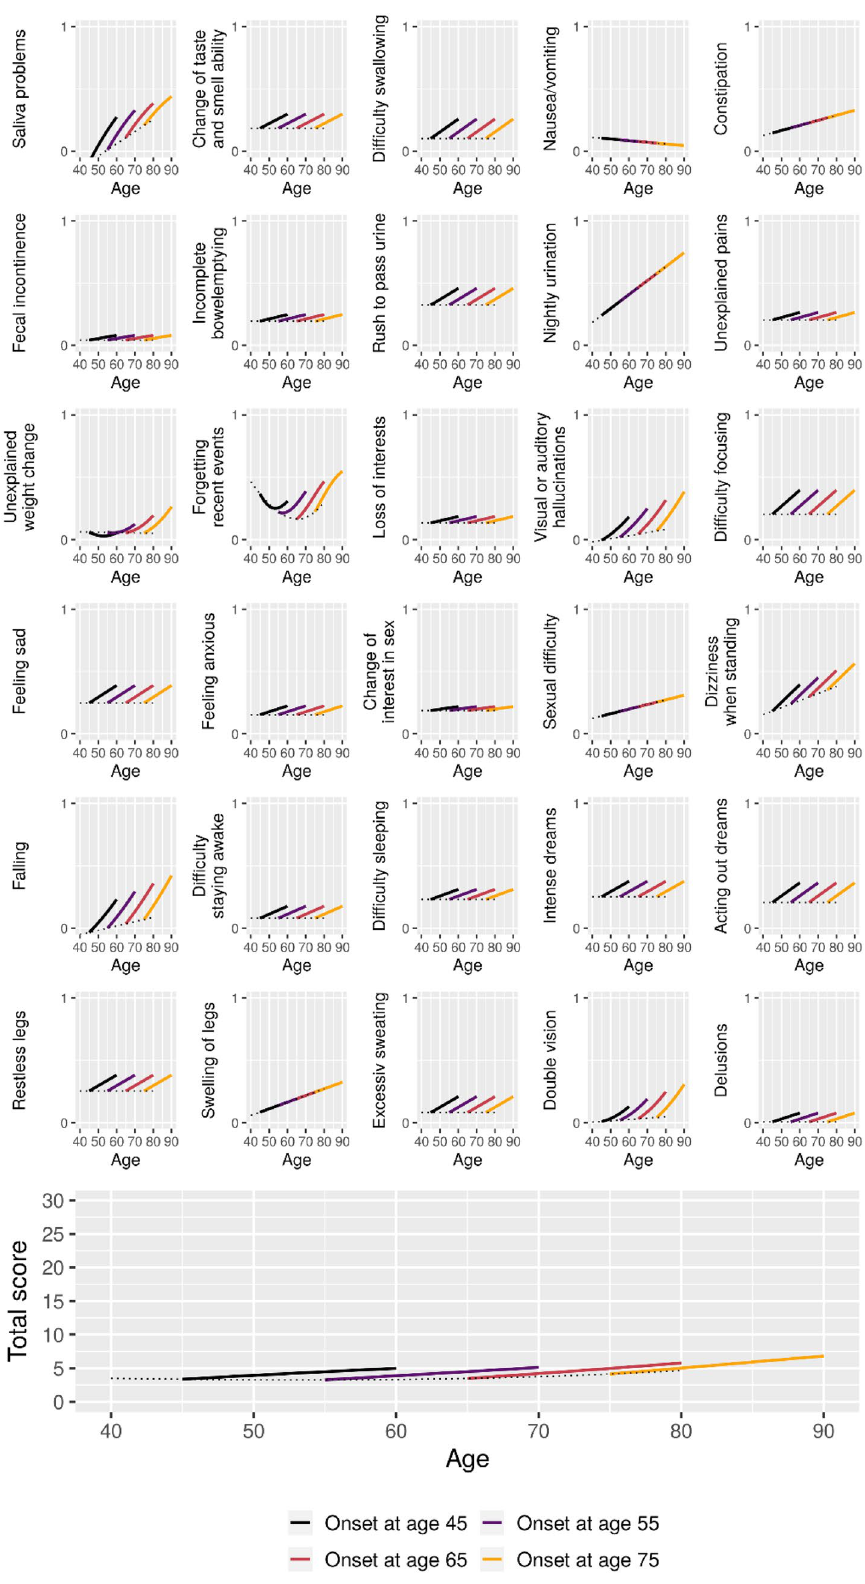
Figure 5. Estimated 15-year mean trajectories of Non-Motor Symptom Questionnaire outcomes from Parkinson’s disease onset at respectively 45, 55, 65, and 75 years of age. Trajectories estimated based on data from 2758 visits. Dotted line represents the estimated mean scores for patients with onset at the given